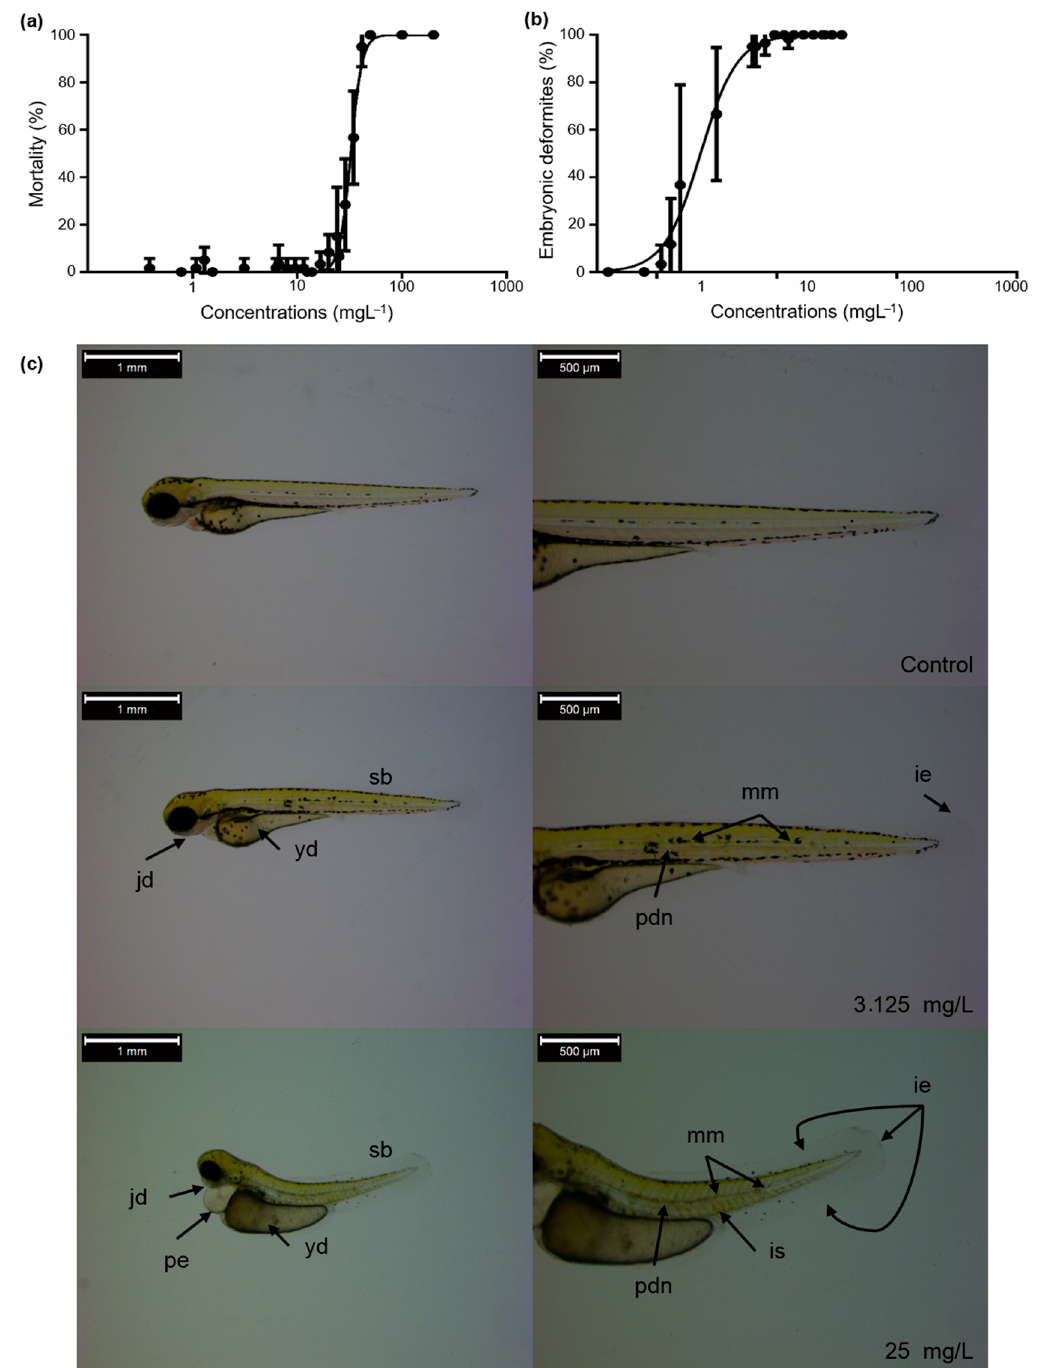
Figure 1. ( a ) Mortality and ( b ) embryonic deformities of zebrafish embryos exposed to various concentrations of bendiocarb during a 96-h test. Error bars indicate the standard deviation of the actual endpoint. ( c ) Some of the detected abnormalities (jd: Not well identifiable jaws; yd: The shape of the yolk is deformed; sb: Shorter body; pe: Pericardial edema; mm: The number and size of the irregular melanocytes; ie: Ventral and caudal fin with moderate, irregular edges; pdn: A portion of the notochord has a poorly defined structure; is: Somite boundaries are slightly irregular) in larval zebrafish exposed to various concentrations of bendiocarb.